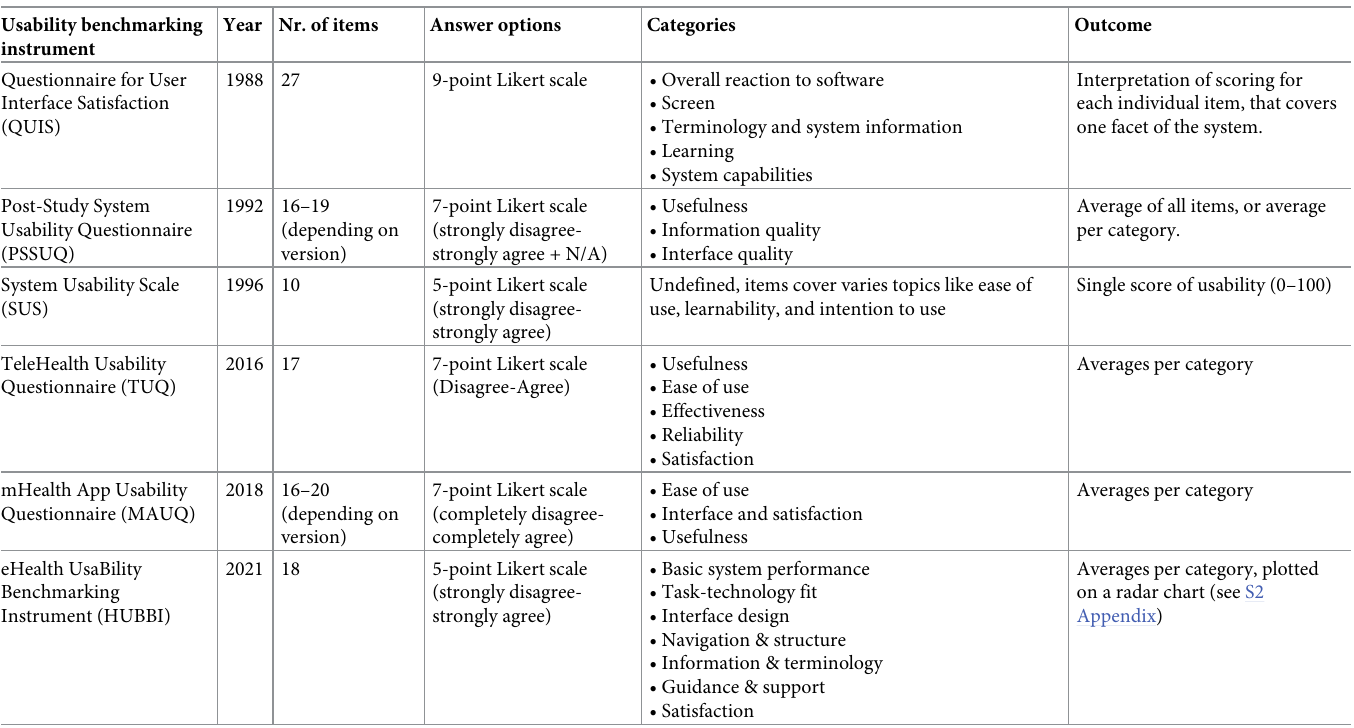
Table 5. Characteristics of usability benchmarking